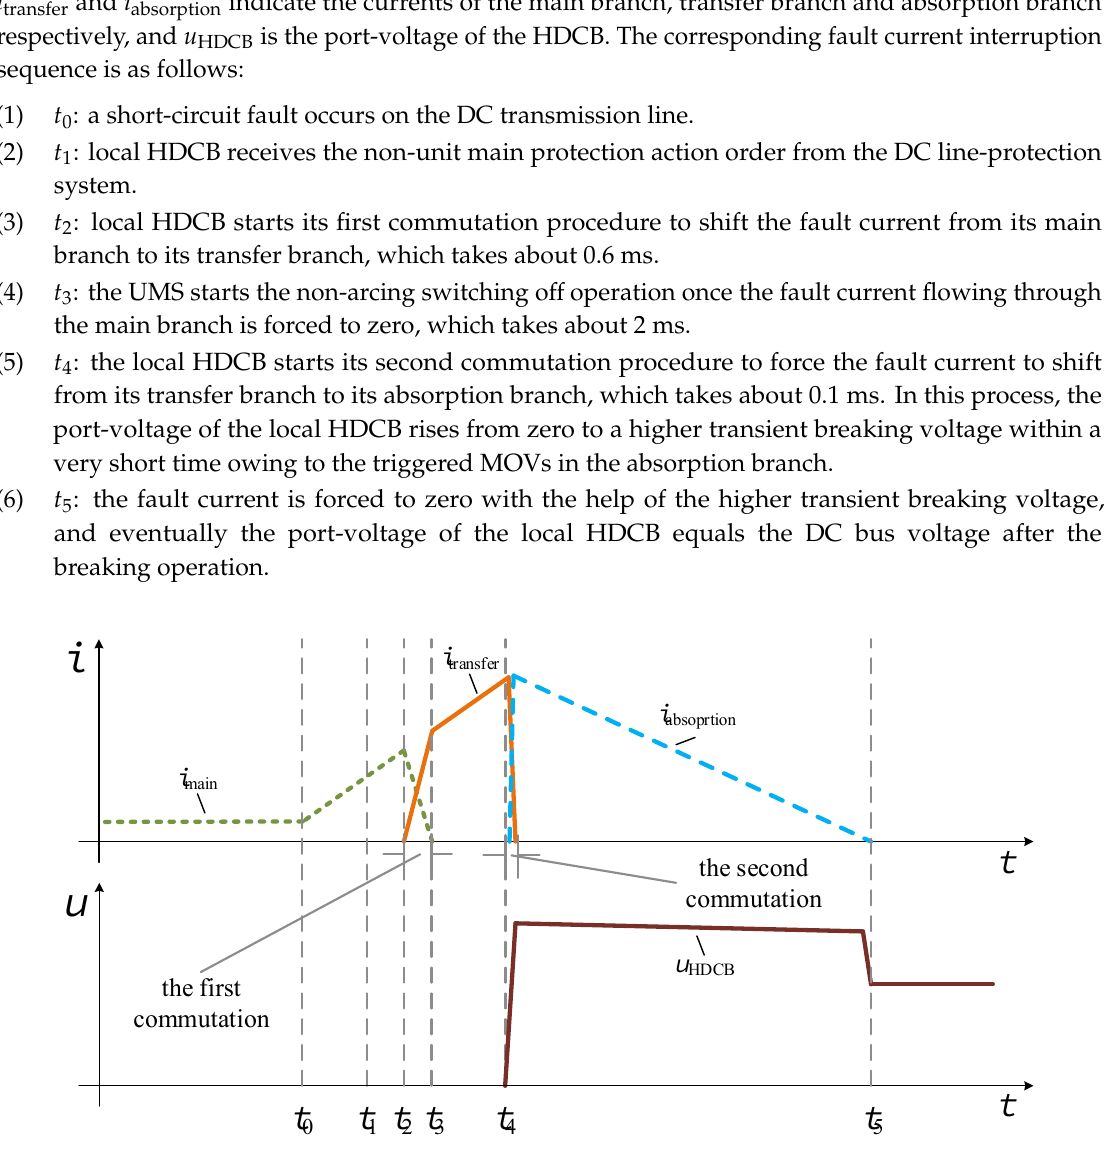
Figure 6. Fault current interruption sequence.